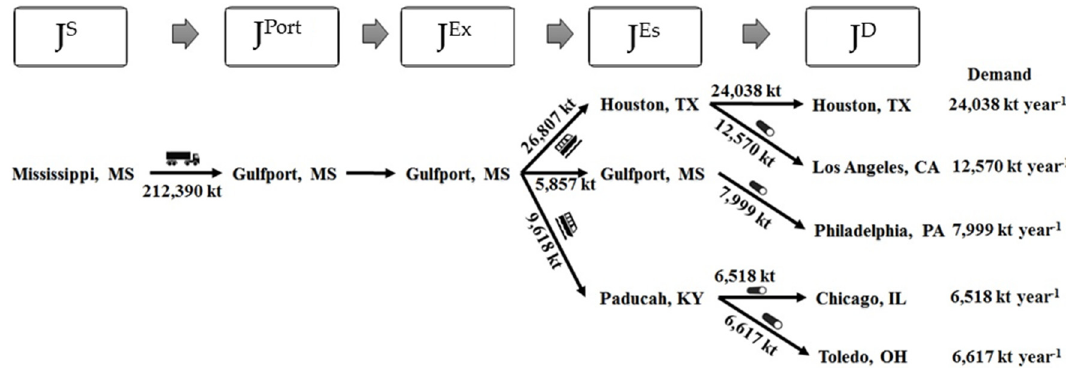
Figure 17. Amount of algae biomass, algae oil, biodiesel being transported between the layers.